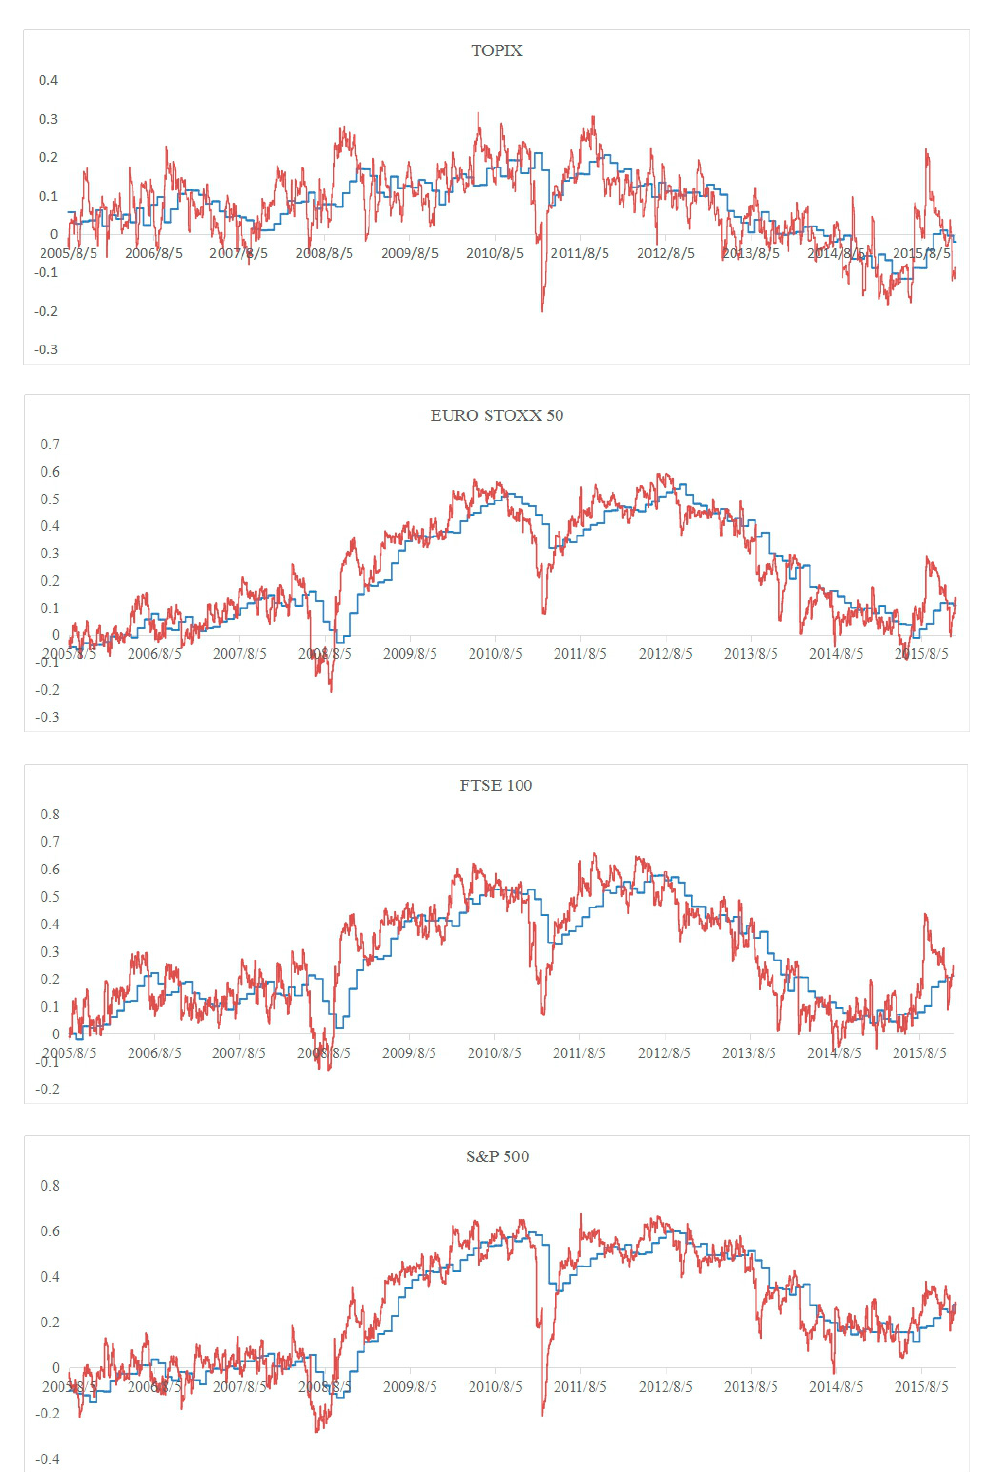
Figure 3. Short- and long-term DCC–MIDAS correlations between oil and stock market prices at the 245